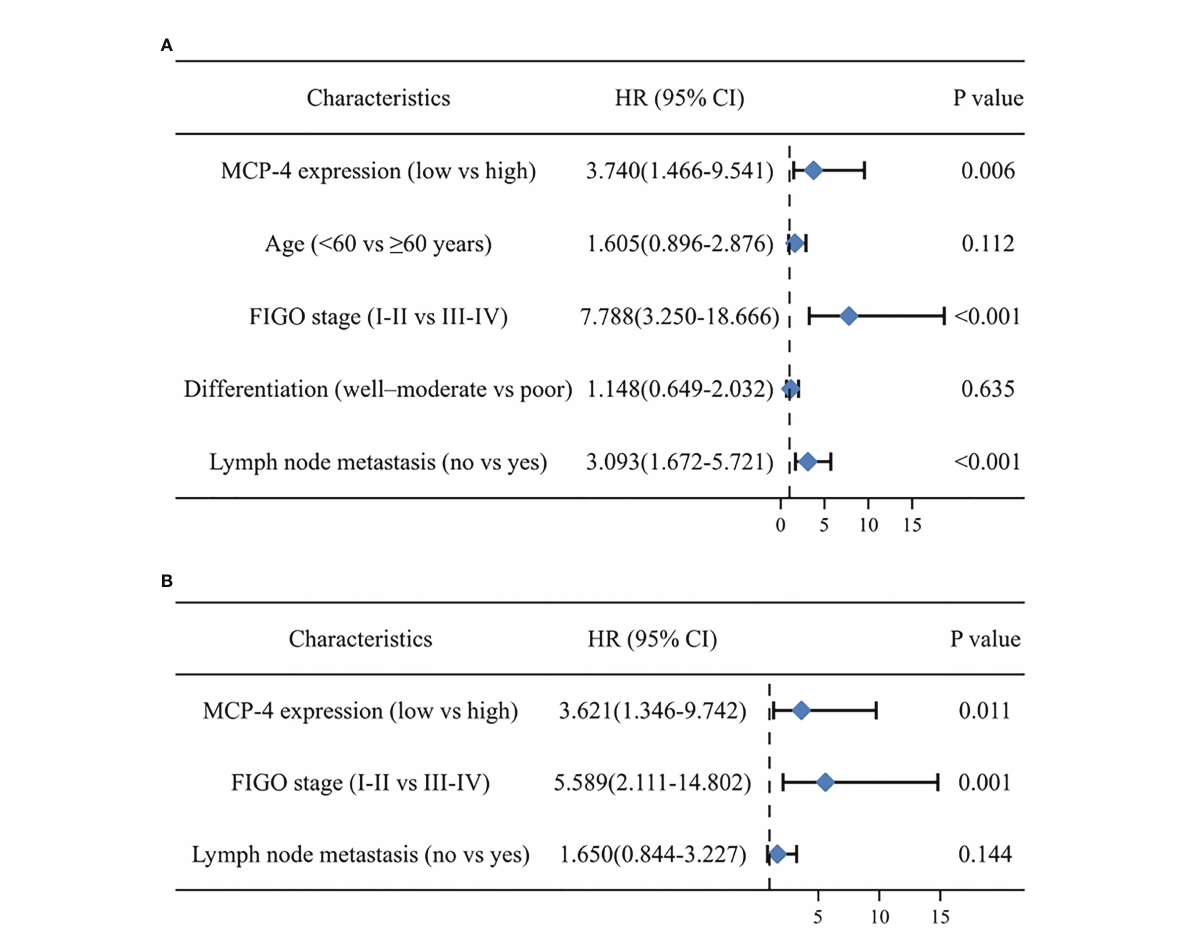
FIGURE 2 Forest map based on univariate (A) and multivariate (B) cox regression